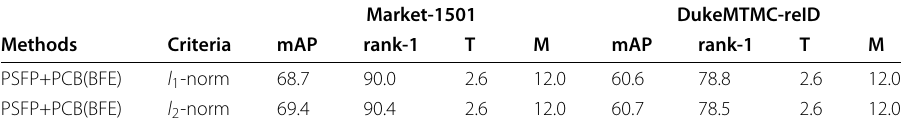
Table 9 Comparison of network accuracy (mAP and rank-1) and complexity (M: Parameters and T: GFLOPS) with different pruning criteria of the PSFP approach on all the person ReID datasets. BFE, backbone feature extractor Market-1501 DukeMTMC-reID